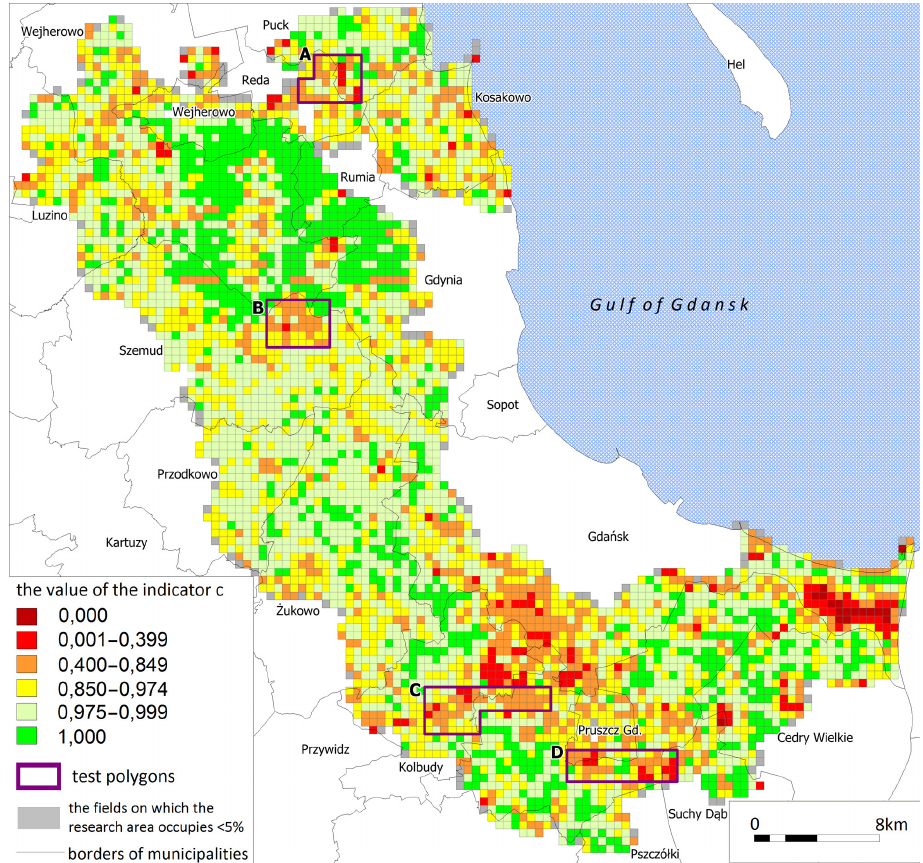
Fig. 2. Spatial distribution of indicator c and location of the testing grounds within the research area. Source: own study.